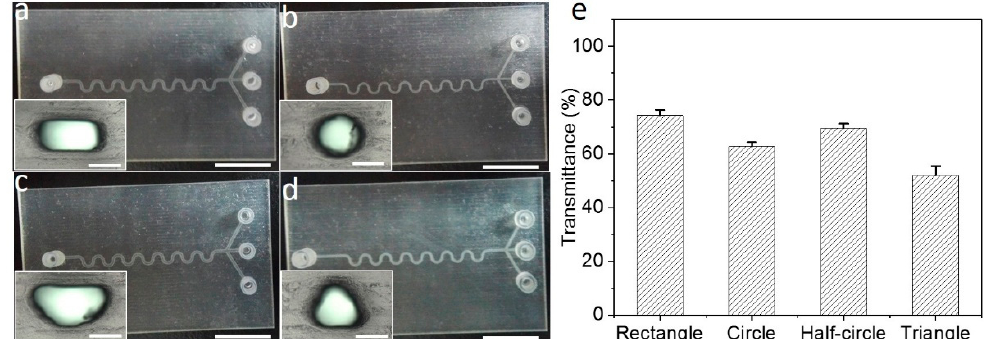
Figure 7. Removing inner sacrificial materials of 3D-printed microfluidic chips. Chips with a ( a ) rectangle, ( b ) circle, ( c ) half-circle, and ( d ) triangle cross-section, respectively. ( e ) The microchannel transmittances of different chips after processing with the optimized engineering technique. The scale bars of full images and enlarged images are 1 cm and 200 μ m, respectively.